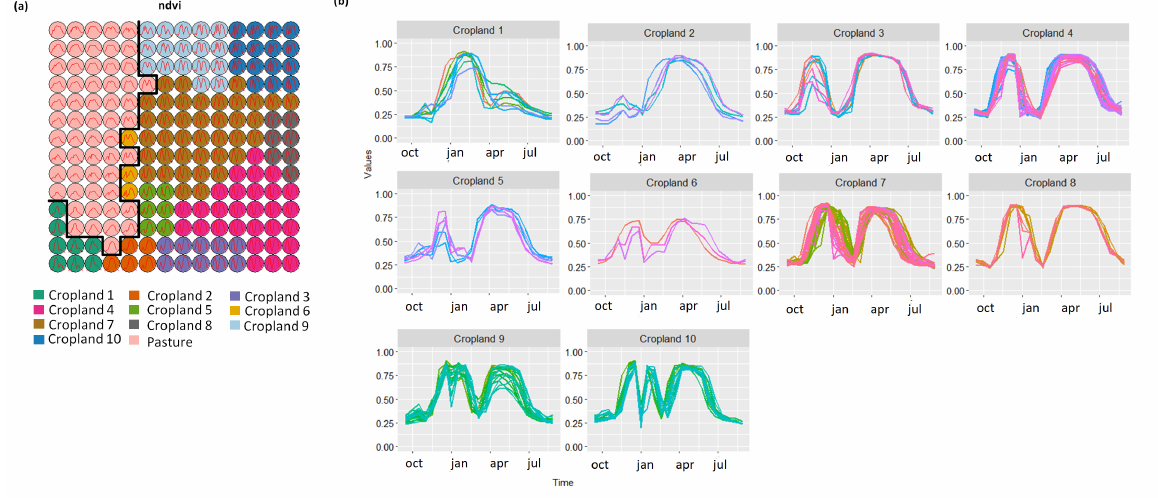
Figure 7. Clusters of cropland. ( a ) SOM grid with subclusters of Cropland. ( b ) Weight vectors of each subcluster. Each line represent a